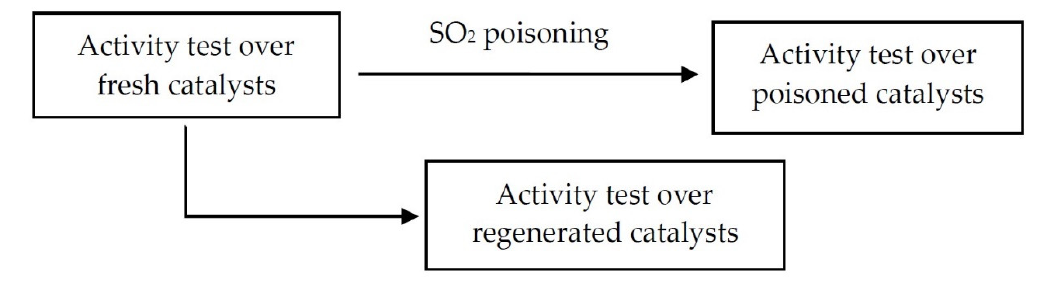
Figure 11. Experimental procedure of the catalytic tests over fresh, poisoned, and regenerated catalysts.